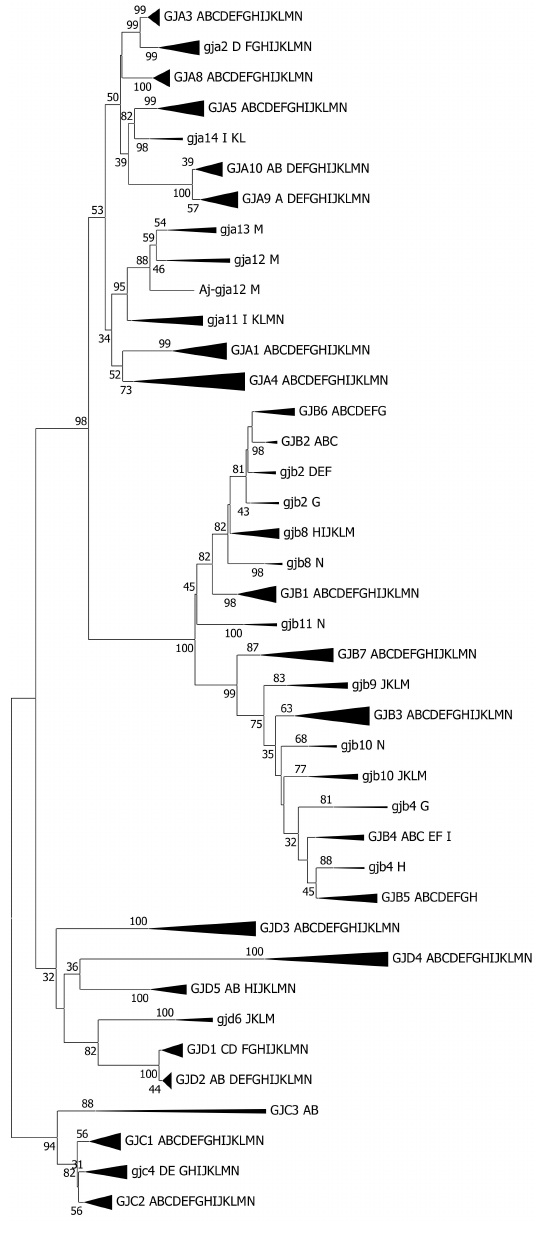
Figure 2. Compressed phylogenetic tree for connexins, except GJE1 , in jawed vertebrates. The orthologous gene groups are indicated by their Greek nomenclature, using upper case letters if mammalian sequences are included in the orthogroup and lower-case letters if mammalian sequences are not included in the group. Sequences belonging to the gje1 / GJE1 group are not included in this tree (see text). The letters at each branch signify the vertebrate groups as follows: A, Placental mammals, B, Marsupials, C, Monotremata (platypus), D, Aves (birds), E, Crocodylia, F, Testudines (turtles), G, Squamata (lizards and snakes), H, Amphibia, I, Lobe-finned fish ( Latimeria ), J, Chondrostei— Polypteriformes (reedfish), K, Chondrostei—Acipenseriformes (sturgeons), L, Holostei (spotted gar), M, Teleostei and N, Chondrichthyes (cartilaginous fishes). A space is left in the sequence of the letters to make it more evident that one or more groups are lacking that particular gene. The tree was constructed on the basis of the amino acid sequence (205 positions and 559 sequences) of the conserved domains by the Neighbor-Joining method using the Jones–Taylor–Thornton (JTT) substitution matrix and with the rate variations among the sites corresponding to a gamma value = 1.1. Bootstrap statistics are shown at the branching points (500 iterations). Bootstrap values below 30 are not shown. The compressed branches are shown in expanded form in Supplementary Figures